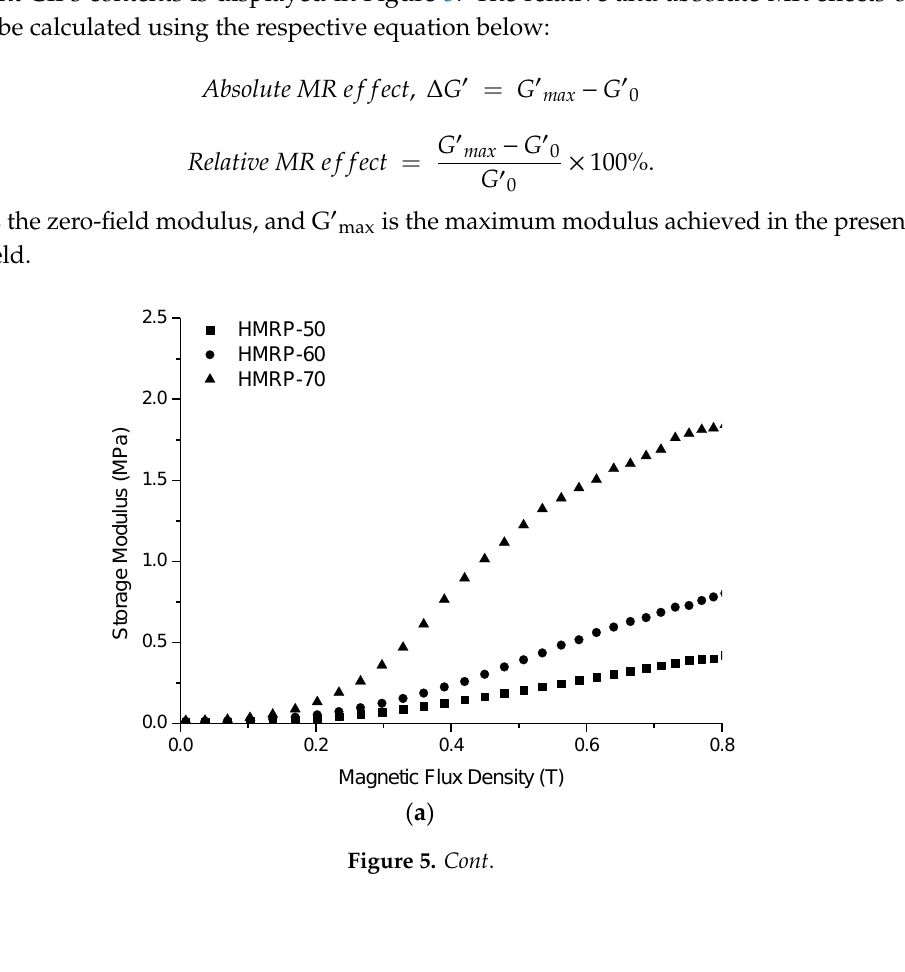
( b ) Figure 5. ( a ) Storage moduli and ( b ) relative magnetorheological (MR) effect of PVA HMRP samples with different CIP contents under different magnetic flux densities. As observed in Figure 5, the G’ of all samples show an increasing pattern with the increase in magnetic flux density from 0 to 800 mT. The curve reveals that the CIPs content has a great influenced on G’, where the sample with a higher loading of CIPs (HMRP-70) exhibited notable changes at the highest G’. For instance, at B = 800 mT, the maximum G’ of samples HMRP-50, HMRP-60, and HMRP-